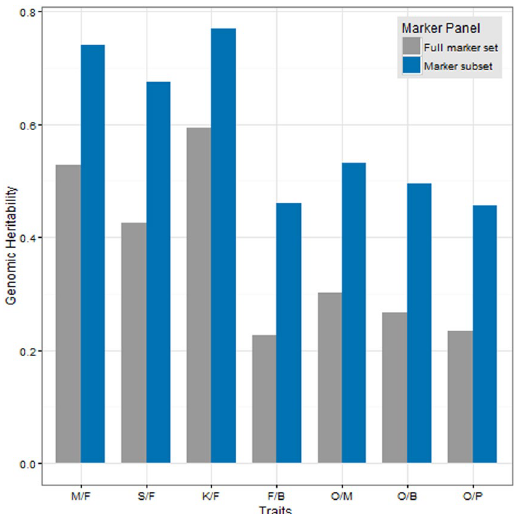
Figure 1. Genomic heritability estimate for 7 traits using the full marker set against marker subset based on association